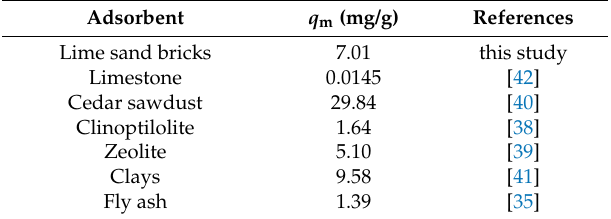
Table 5. The adsorption capacity of the adsorbent for copper in water treatment. Adsorbent